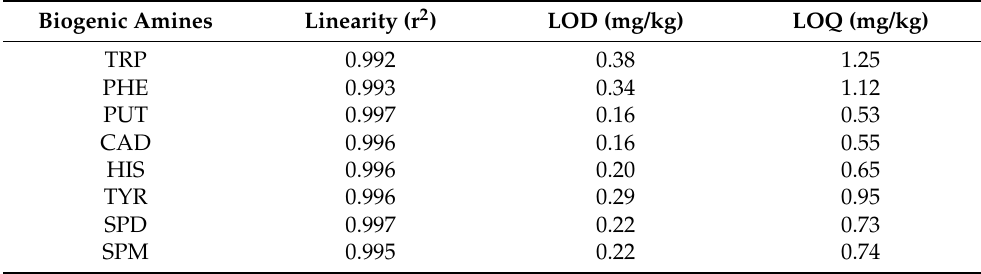
Figure 1. Representative c hromatographic separation of the biogenic amines in standard solution. Table 1. Results of the validation parameters for the biogenic amines in